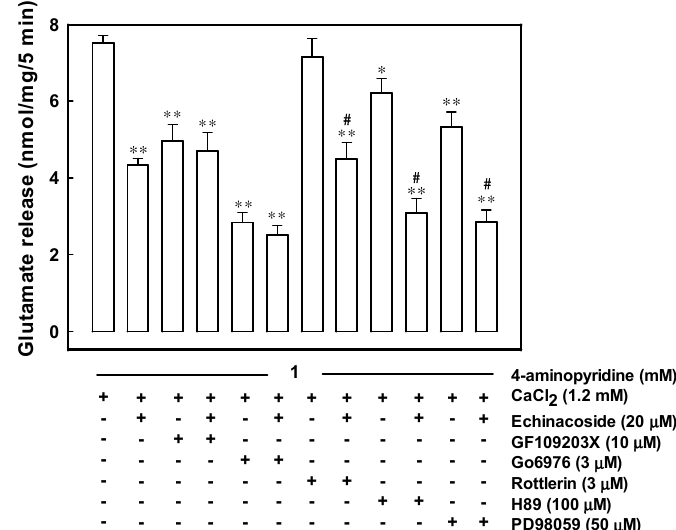
Figure 3. Echinacoside-mediated inhibition of 4-aminopyridine-evoked glutamate release is blocked by protein kinase C inhibitors. Glutamate release was evoked by 1 mM 4-aminopyridine in the absence (control) or presence of 20 µ M echinacoside, 10 µ M 2-[1-(3-dimethylaminopropyl)indol-3- yl]-3-(indol-3-yl) maleimide (GF109203X), 10 µ M GF109203X and 20 µ M